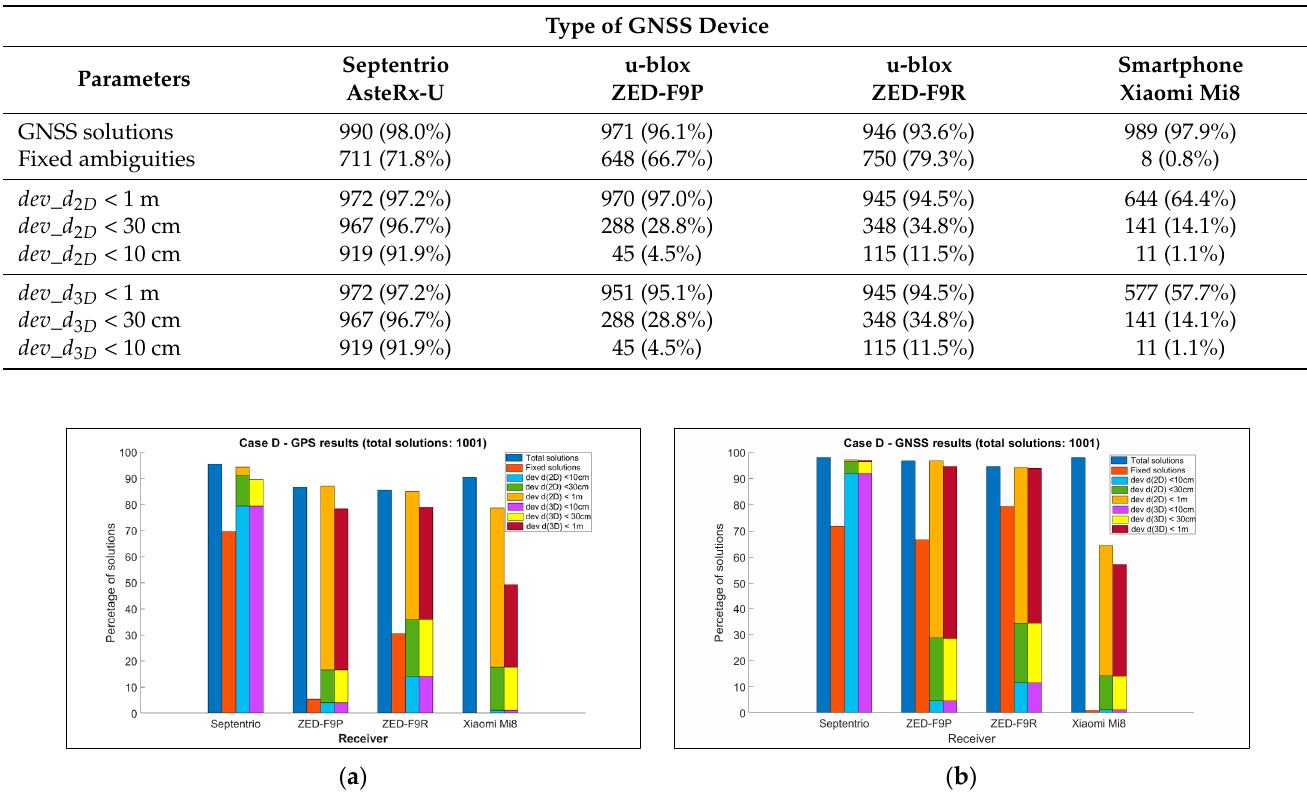
Table 14. GNSS solutions, solutions with fixed ambiguities, and deviation of distances below the given threshold. Situation Case D—open sky conditions with vegetation by the roadside (no. of total: 1001).